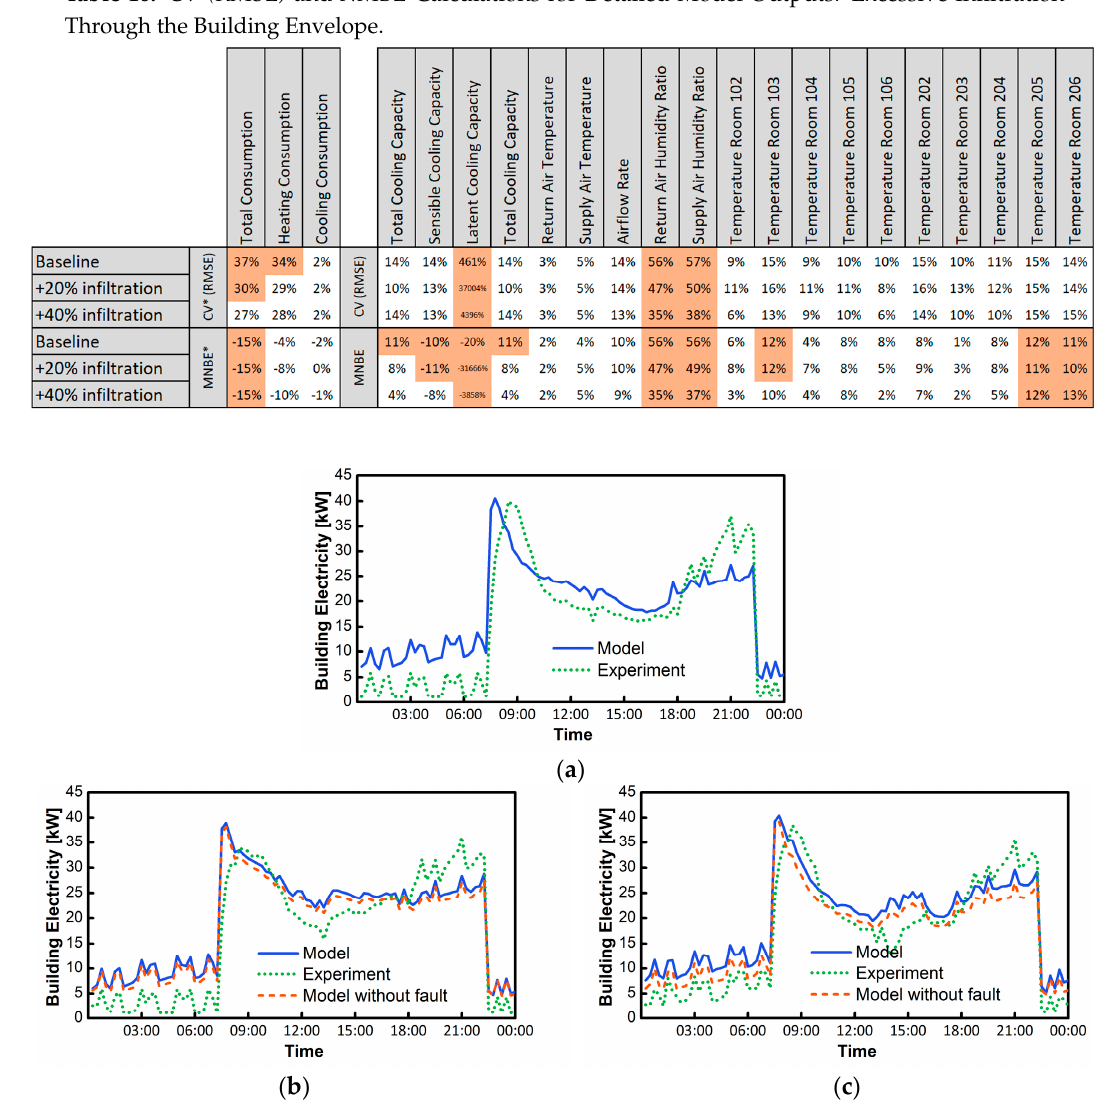
Figure 13. Total building electricity consumptions of baseline and faulted scenarios: Excessive infiltration through the building envelope. ( a ) baseline; ( b ) +20% infiltration; ( c ) +40% infiltration.